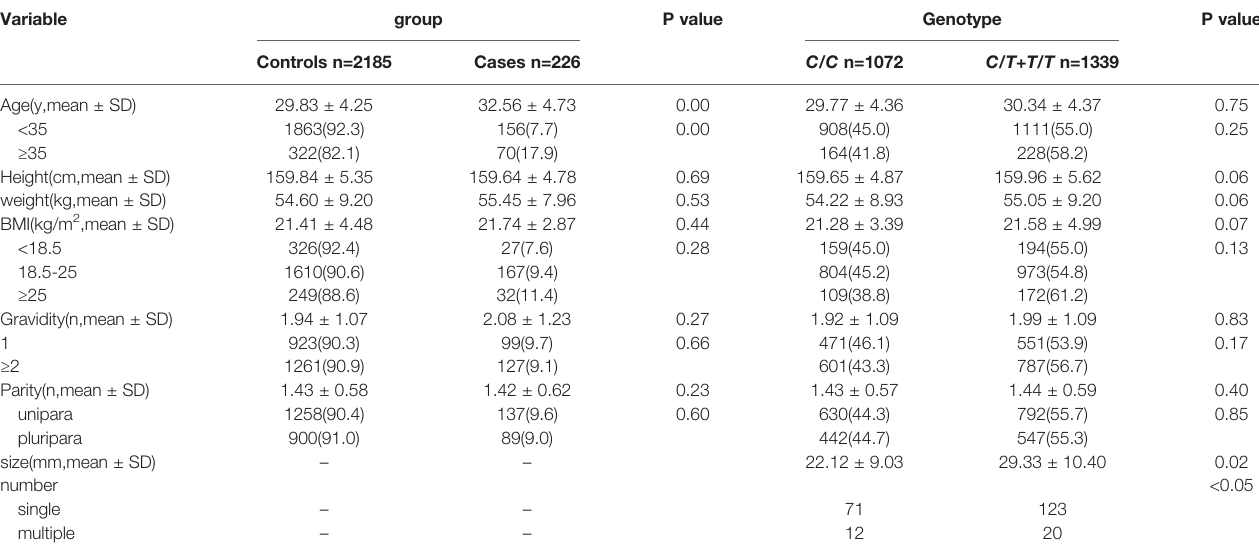
TABLE 1 | General characteristics of study